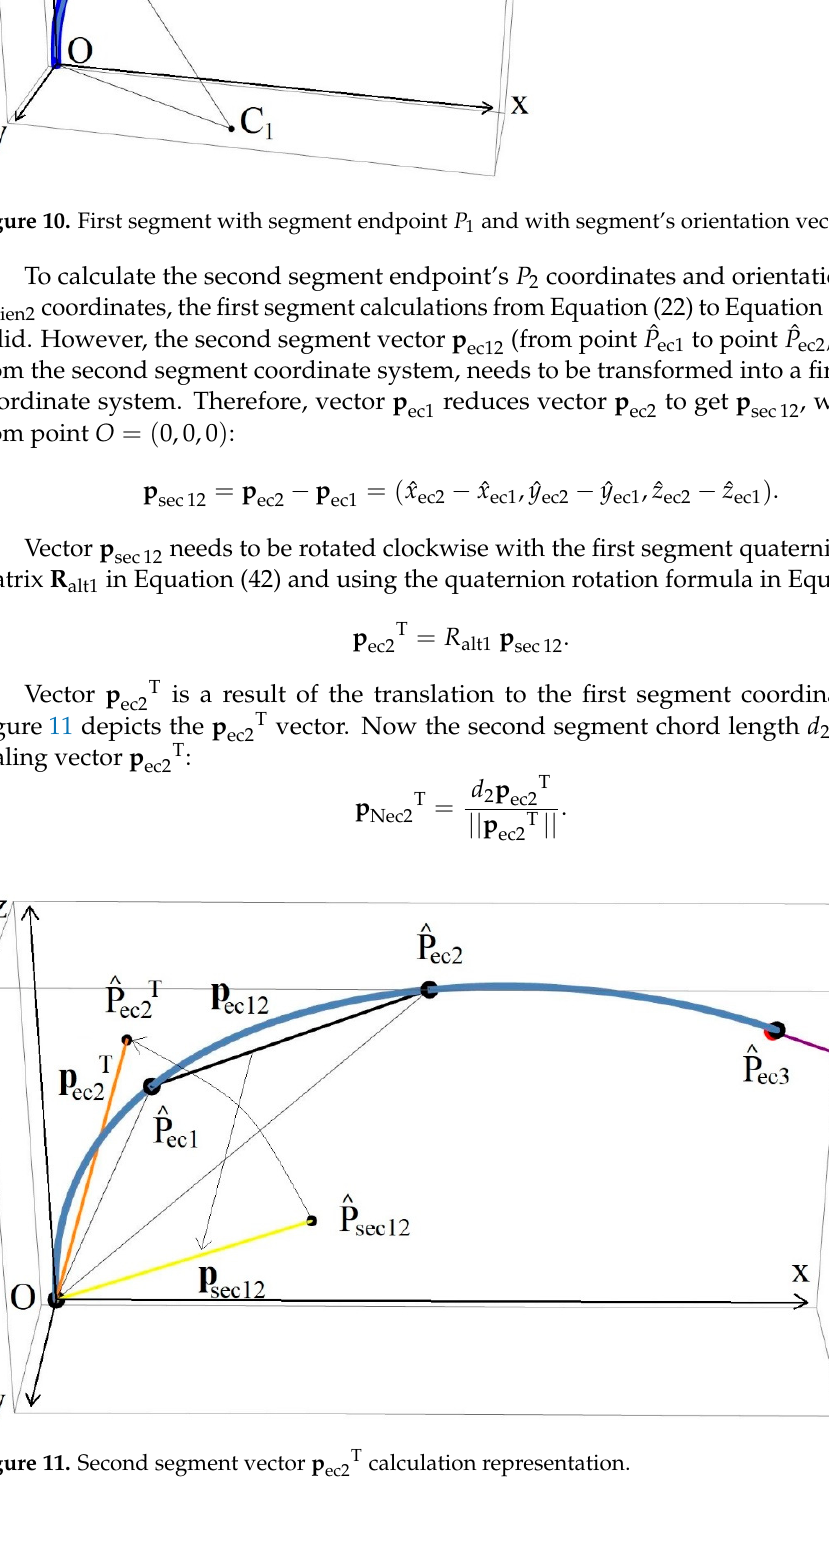
Figure 12. Second segment endpoint (cid:1842) (cid:2870)(cid:2904) and orientation vector (cid:1819) (cid:2925)(cid:2928)(cid:2919)(cid:2915)(cid:2924)(cid:2898)(cid:2870)(cid:2904) in the first segment’s coordinate system. Translation of the second robot segment endpoint (cid:1842) (cid:2870)(cid:2904) , arc center point (cid:1829) (cid:2870)(cid:2904) , and ori- entation vector (cid:1819) (cid:2925)(cid:2928)(cid:2919)(cid:2915)(cid:2924)(cid:2870)(cid:2904) back to the second segment coordination system requires their rotation according to the first segment counter-clockwise quaternion rotation matrix in Equation (41). After that, (cid:1842) (cid:2870)(cid:2904) , (cid:1829) (cid:2870)(cid:2904) and (cid:1819) (cid:2925)(cid:2928)(cid:2919)(cid:2915)(cid:2924)(cid:2898)(cid:2870)(cid:2904) add to the first segment endpoint (cid:1842) (cid:2869) .